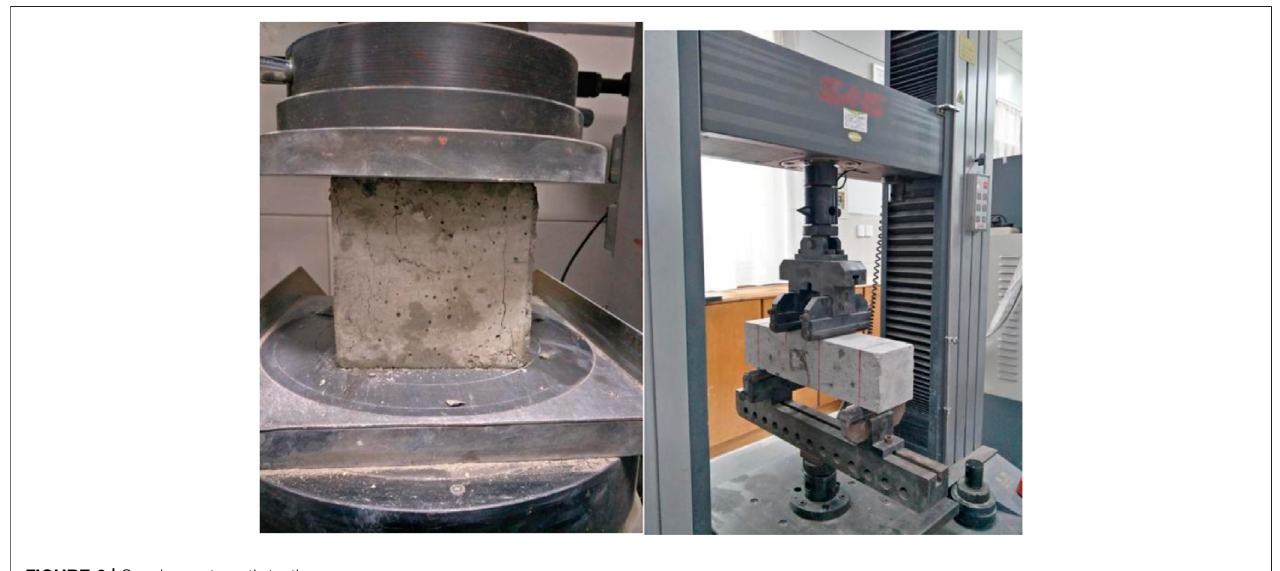
FIGURE 2 | Specimen strength